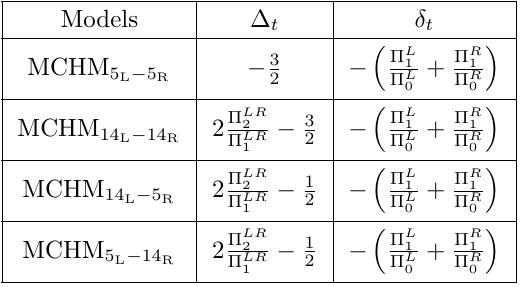
Table 5. Expressions for (cid:1) t and (cid:14) t for di(cid:11)erent representations of SO(5) in which top quark is